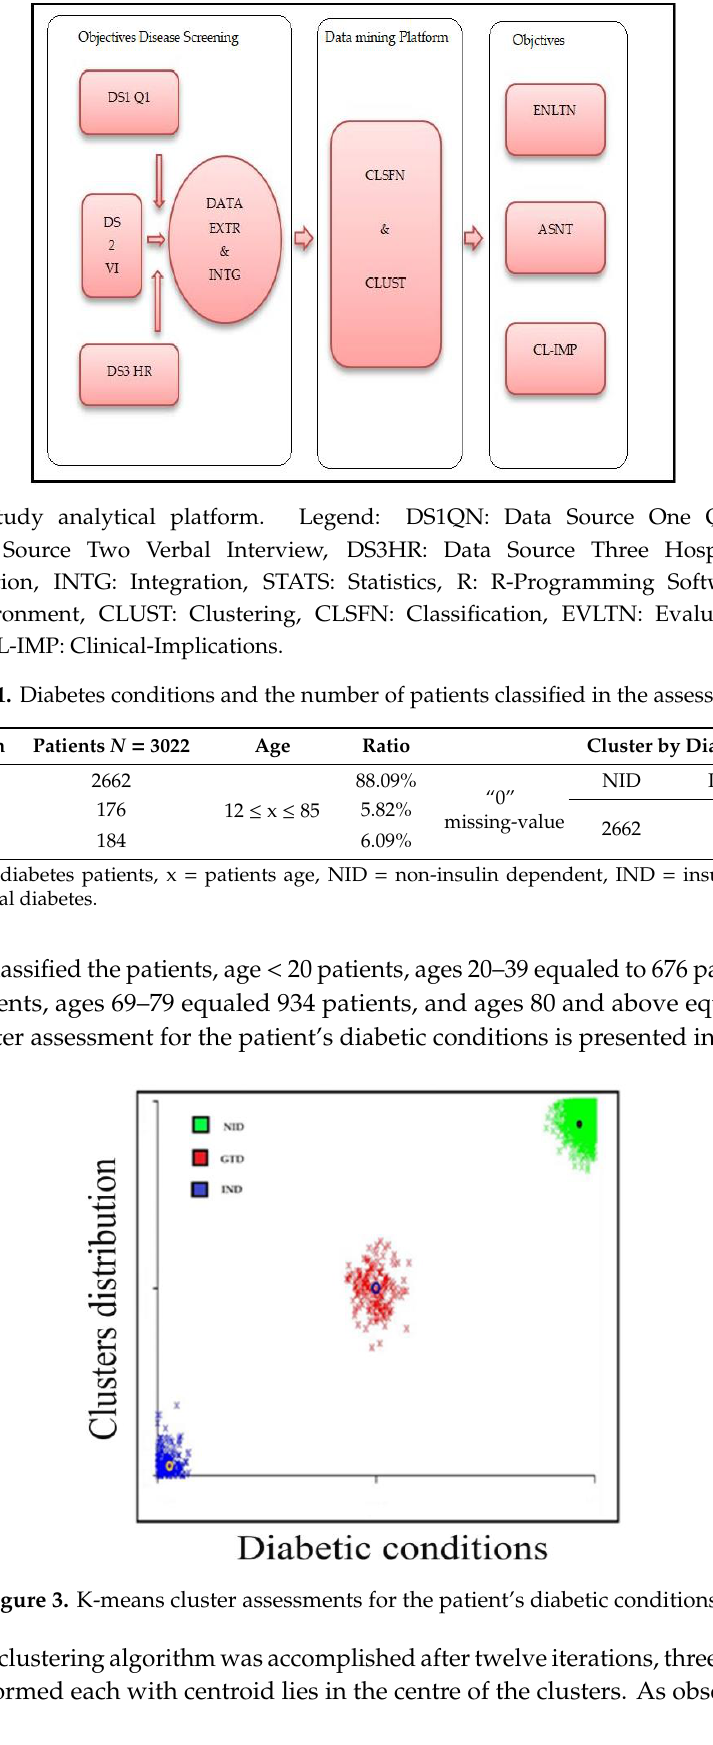
Figure 3. K-means cluster assessments for the patient’s diabetic conditions.